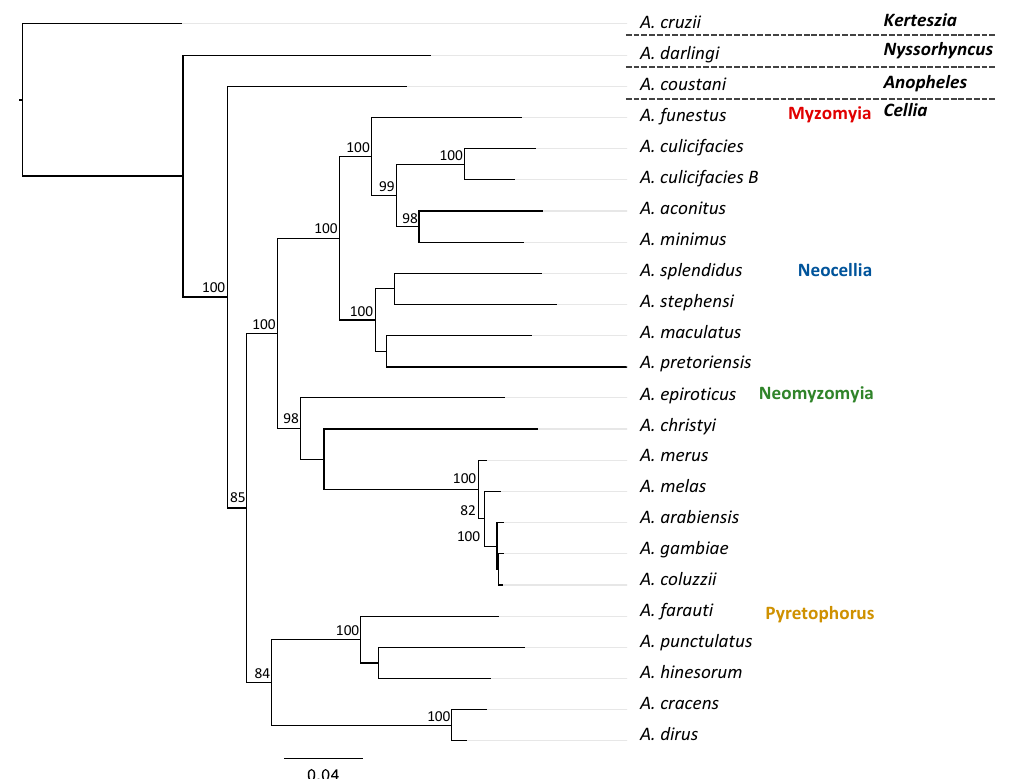
Figure 2. Phylogenetic relationships of Anopheles species based on mitogenomes. Maximum-likelihood phylogeny was constructed with sequence of 13 protein coding genes from 21 species of Anopheles from the four series within the subgenus Cellia , including the newly sequenced A. pretoriensis . One species from each of the subgenera: Anopheles , Nyssorhyncus and Kerteszia . Branch values indicate bootstrap replications (displayed values > 80).